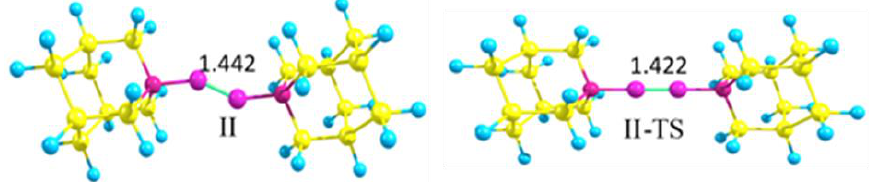
Figure 1. Zigzag structure of bis-1-azaadamantane-boryne adduct (II) and transition structure with the linear NBBN fragment (II-TS) (M06-2X/cc-pVDZ calculations).